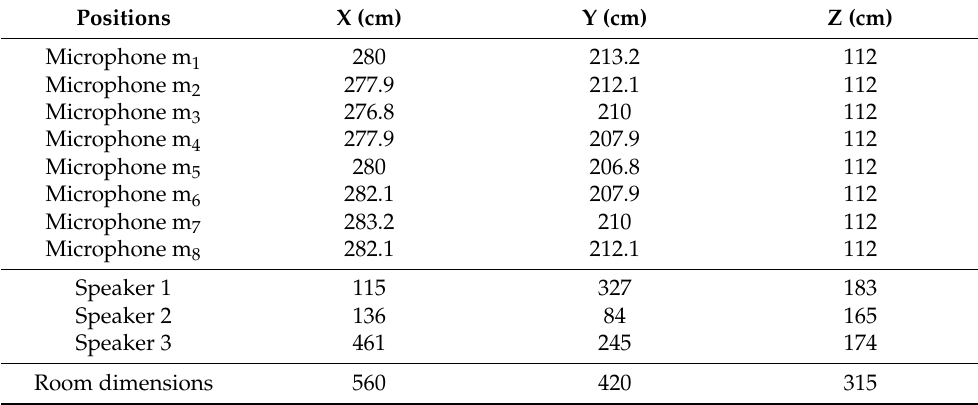
Table 1. The exact locations of speakers, circular microphones, and room